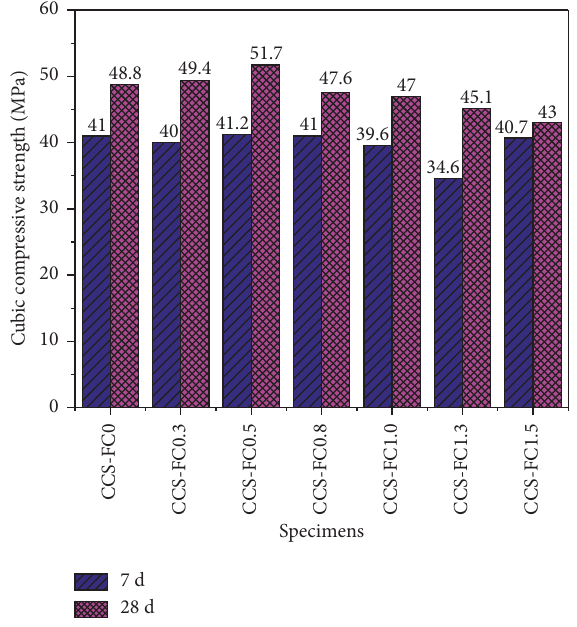
Figure 6: ARGFRC cubic compressive